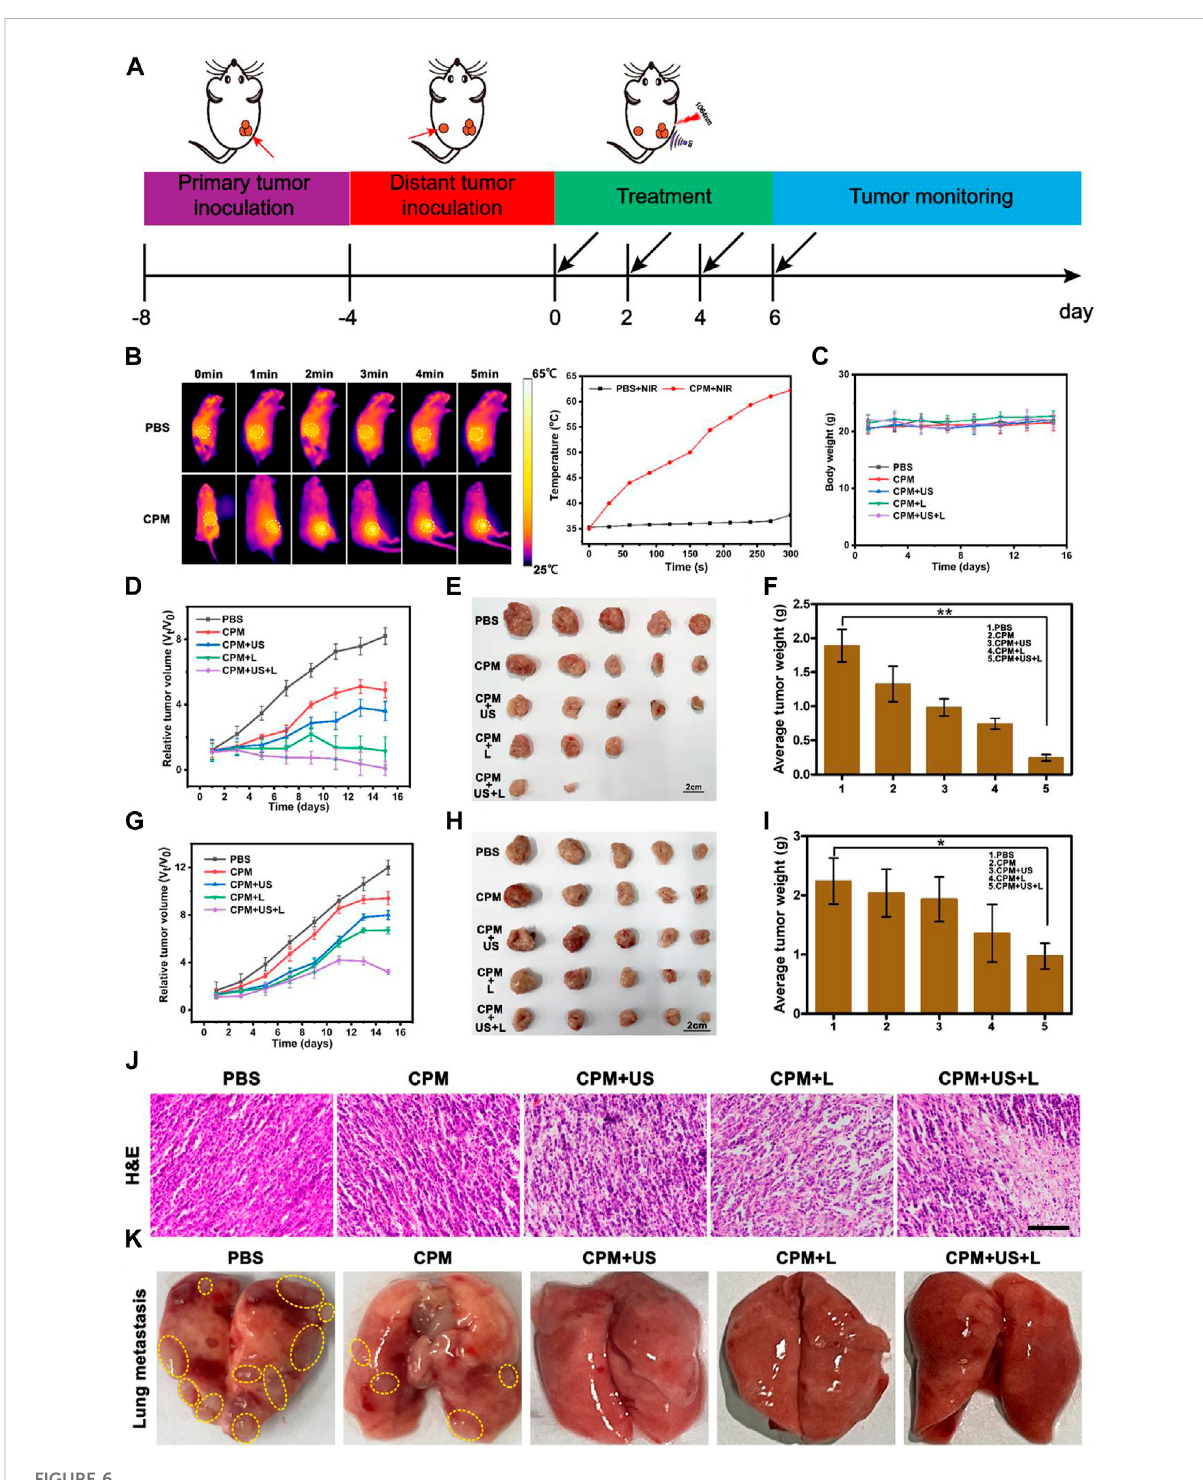
FIGURE 6 (A) Schematicillustrationoftheanimaltumormodelandtreatmentprocess. (B) InfraredthermographicimagesofmiceinPBS+NIRandCPM+ NIR groups and the corresponding temperatures curves of mice. (1,064 nm, 1 W cm − 2 , 5 min). (C) Average body weight curves during treatment. (D) Relative tumor volumes-time curves of 4T1 primary tumors in mice after varioustreatments. (E) Representative tumor pictures of 4T1 primary tumor and (F) average tumor weights obtained on the 15 th day. (G) Relative tumor volumes-time curve of 4T1 distant tumors in mice after various treatments. (H) Representative tumor pictures of 4T1 distant tumor and (I) average tumor weights obtained on the 15 th day. Data are means ± SD, * p < 0.05. (J) H and E staining images of primary tumors tissues. (Scale bar: 100 μ m). (K) Representative photographs of lung tissues after various